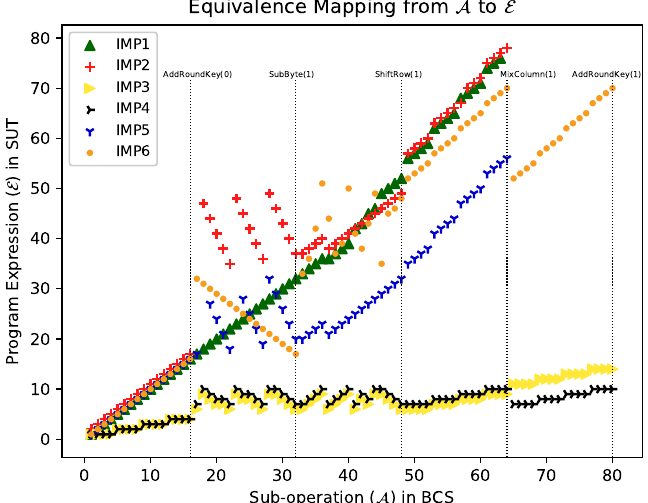
Figure 9: Equivalence Mapping output for a single round of the AES implementations given in Table 2. The x-axis denotes the sub-operations in BCS and y-axis is the corresponding program expression in